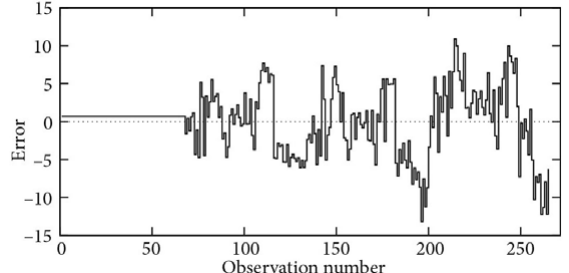
Fig. 4. Graph of residuals by observation number Table 4. Results of the heteroscedasticity tests Heteroscedasticity Test Test statistic value p -value White